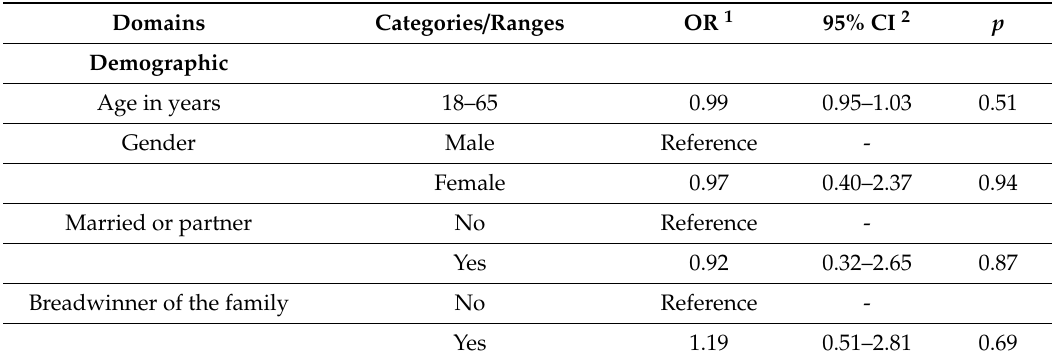
Table 2. Univariable logistic regression analyses of all potential predictors for staying at work for participants with subjective health complaints